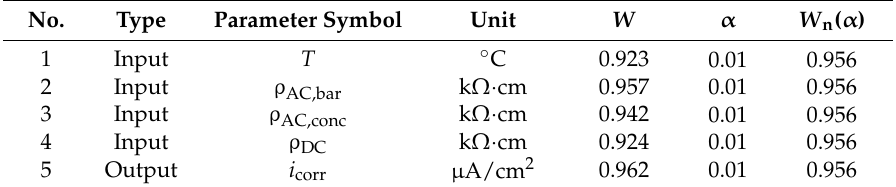
Table 3. Results of the Shapiro-Wilk